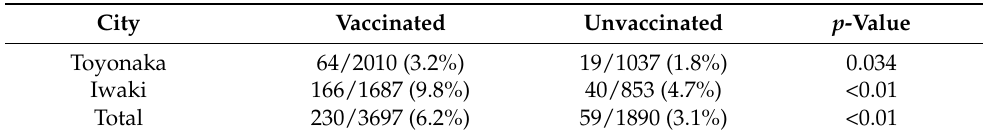
Table 1. Cervical cancer screening rates in vaccinated and unvaccinated women, aged 20 and 21, born in fiscal year (FY) 1995–1996, studied in Toyonaka and Iwaki, Japan.